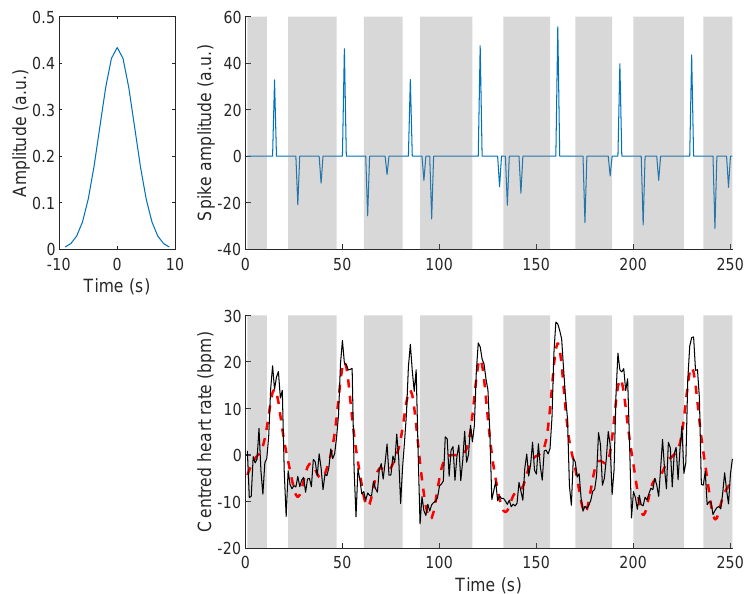
Figure 2. ( Upper left ): reference signal; ( upper right ): sparse model of the heart rate; ( lower right ): high-pass filtered heart rate during a series of consecutive apnoeas (plain black line) and reconstructed heart rate (dashed red line) using the reference signal and the series of spikes. Apnoeas are highlighted by the grey patches.